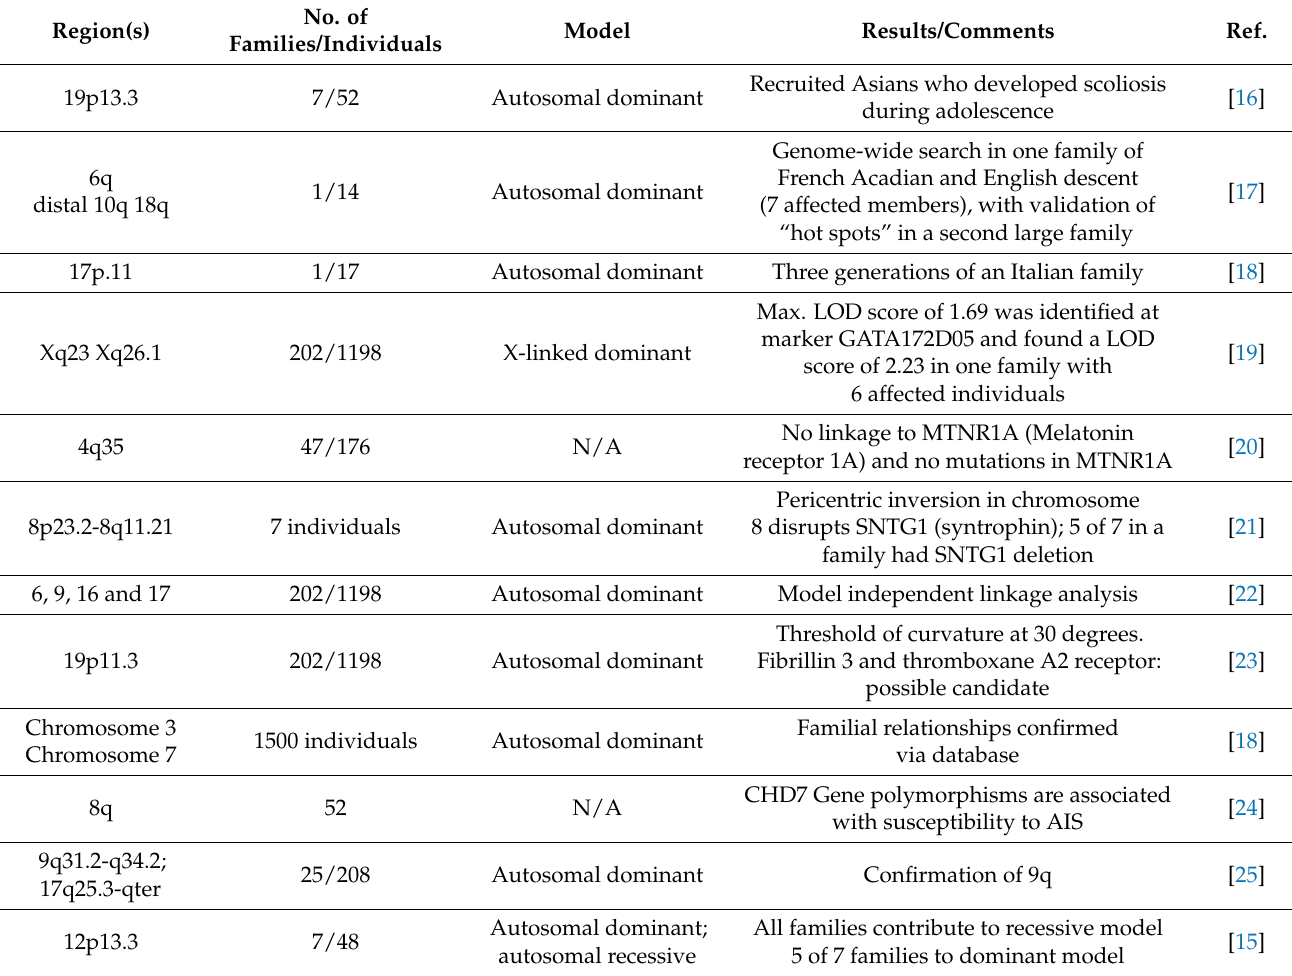
Table 1. Summary of current genetic linkage studies for AIS. Modified from